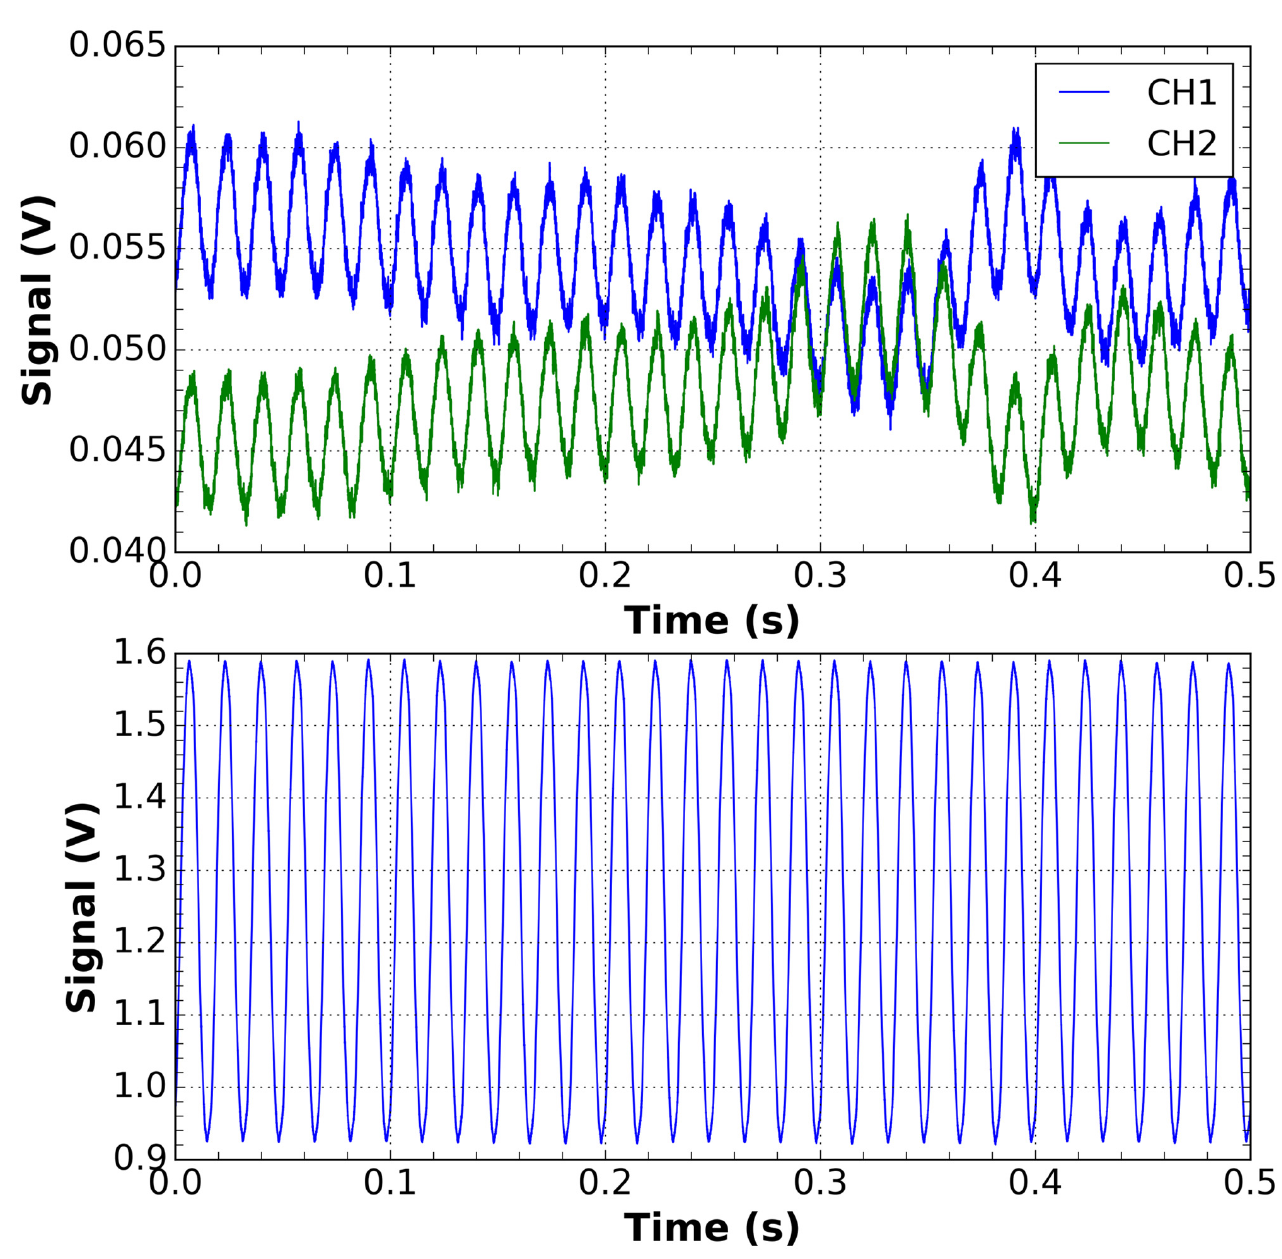
Figure 6. Waveforms of the CH1 and CH2 channels of the current sensor output in the presence of a disturbance with an applied current of 240 A.